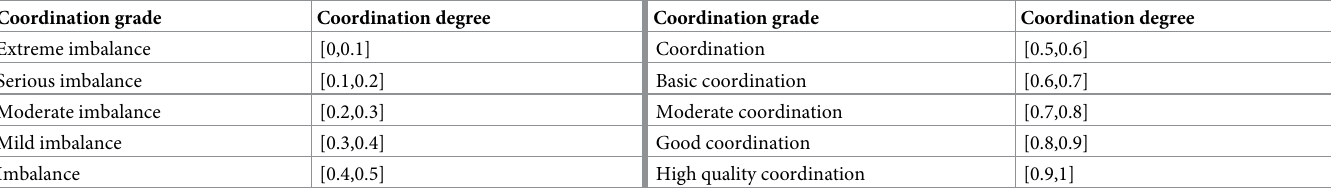
Table 3. Coupling coordination grade and